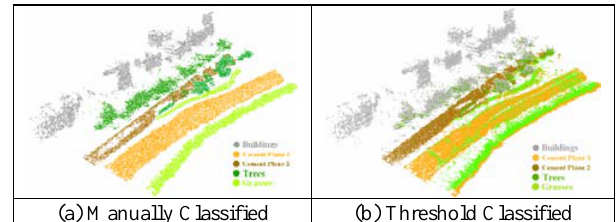
Figure 7. Different classification